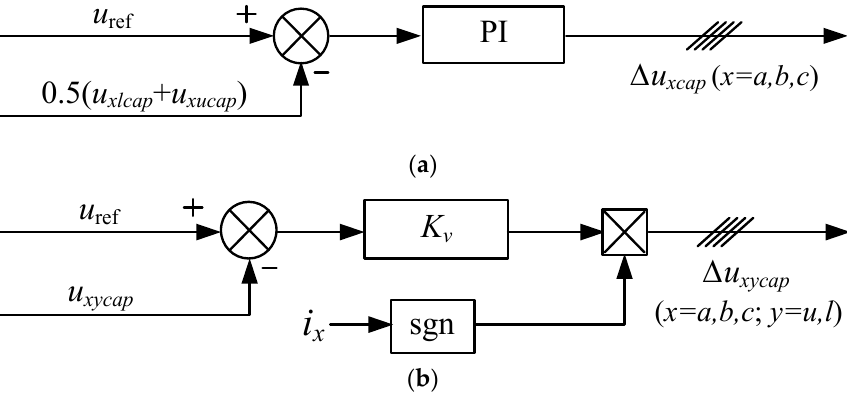
Figure 14. Control diagram of the proposed SCSM. ( a ) Average control of the capacitor voltages. ( b ) Individual control of the capacitor voltages.